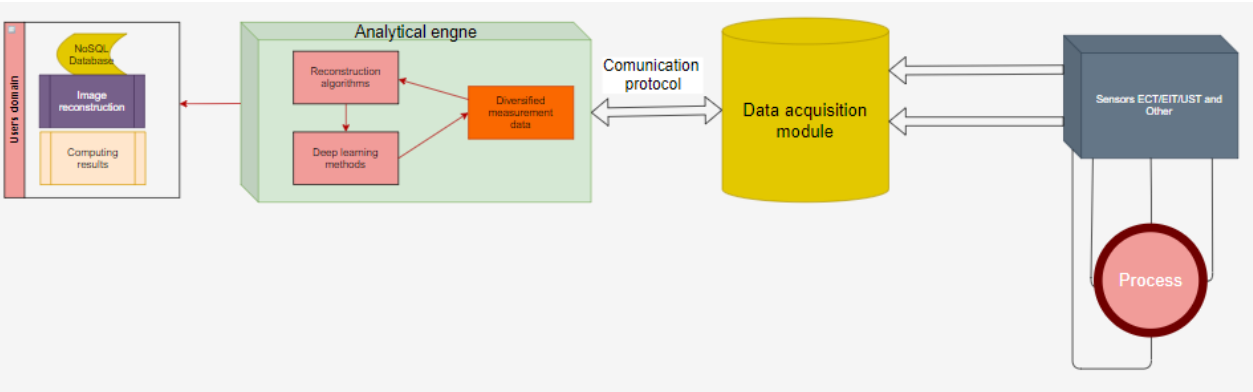
Figure 1. Model of a tomographic sensor platform with an analytical system.